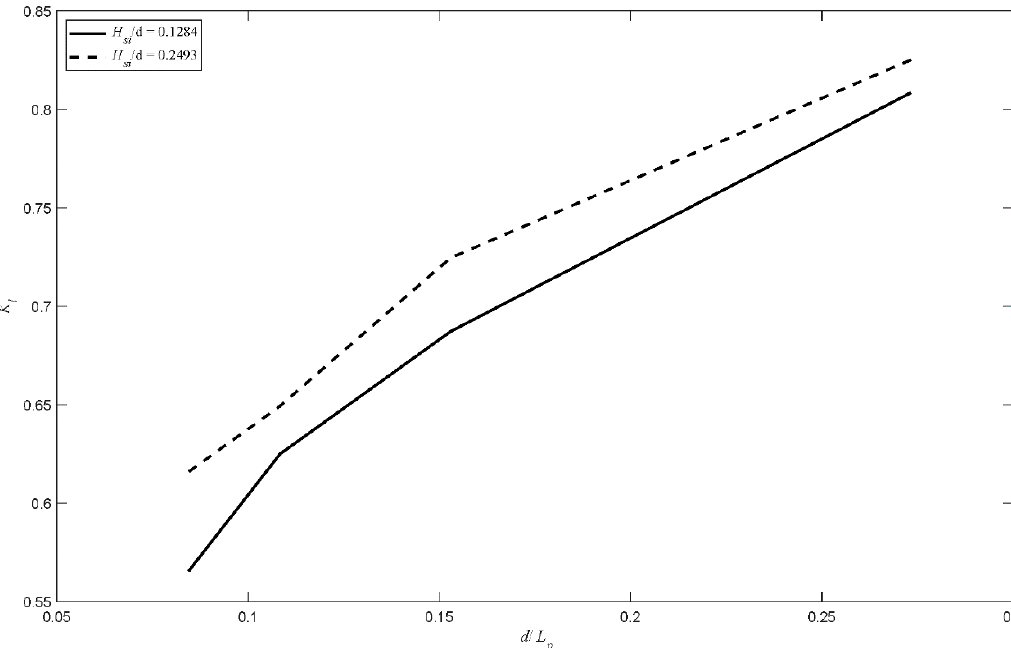
Figure 25. Effect of 𝐻 (cid:3036)(cid:3046) / 𝑑 on the variation of 𝐾 (cid:3039) with 𝑑 / 𝐿 (cid:3043) . N = 1, P = 20%, and θ = 90°. Figure 25. E ff ect of H